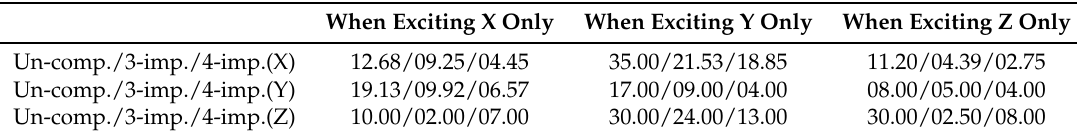
Figure 4. Compensated and uncompensated output responses with different shaper designs—simulation. Table 1. Settling time for all